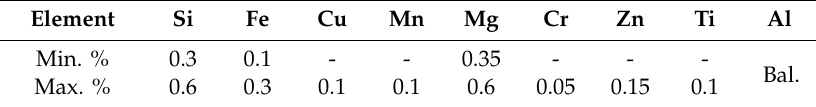
Table 1. Chemical composition of AA-6060.